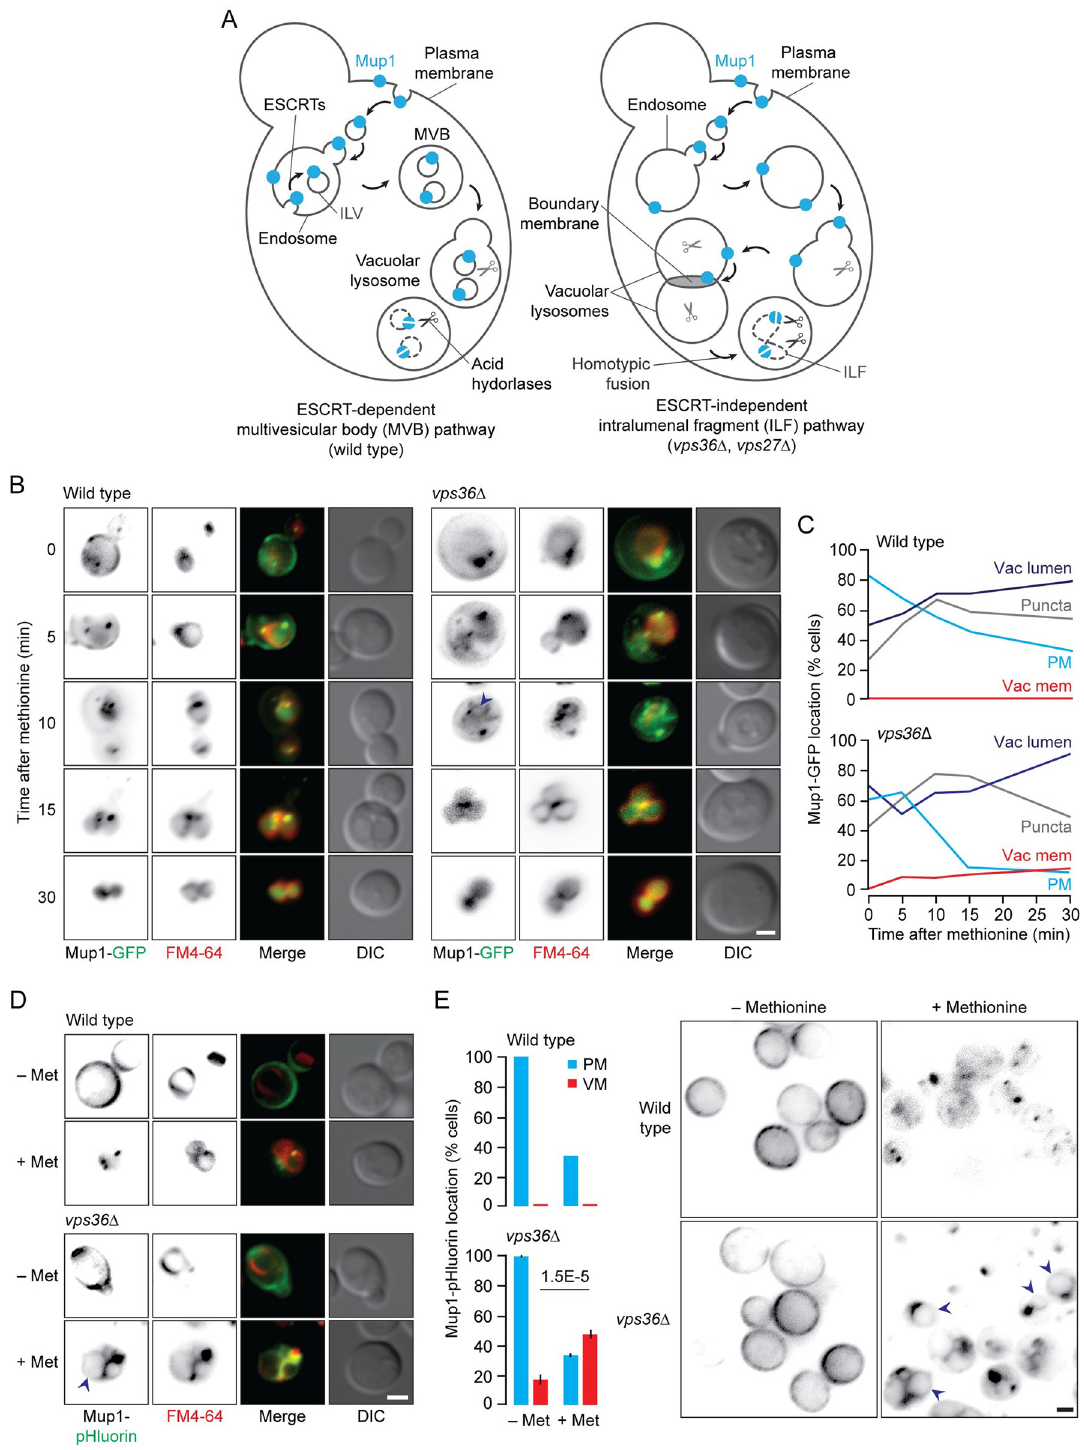
Fig 1. Mup1 accumulates on vacuole membranes in vps36 Δ cells after addition of methionine. (A) Illustration describing how surface ESCRT-client proteins like Mup1 may be rerouted to the vacuole membrane and ILF pathway for degradation when MVB formation is blocked. (B) Fluorescence and DIC micrographs showing route taken by Mup1-GFP from the plasma membrane to the vacuole lumen in response to methionine over 30 minutes in live wild type or vps36 Δ cells stained with FM4-64. (C) Proportion of wild type or vps36 Δ cells that show Mup1-GFP fluorescence on the plasma membrane (PM), intracellular puncta, vacuole membrane (Vac